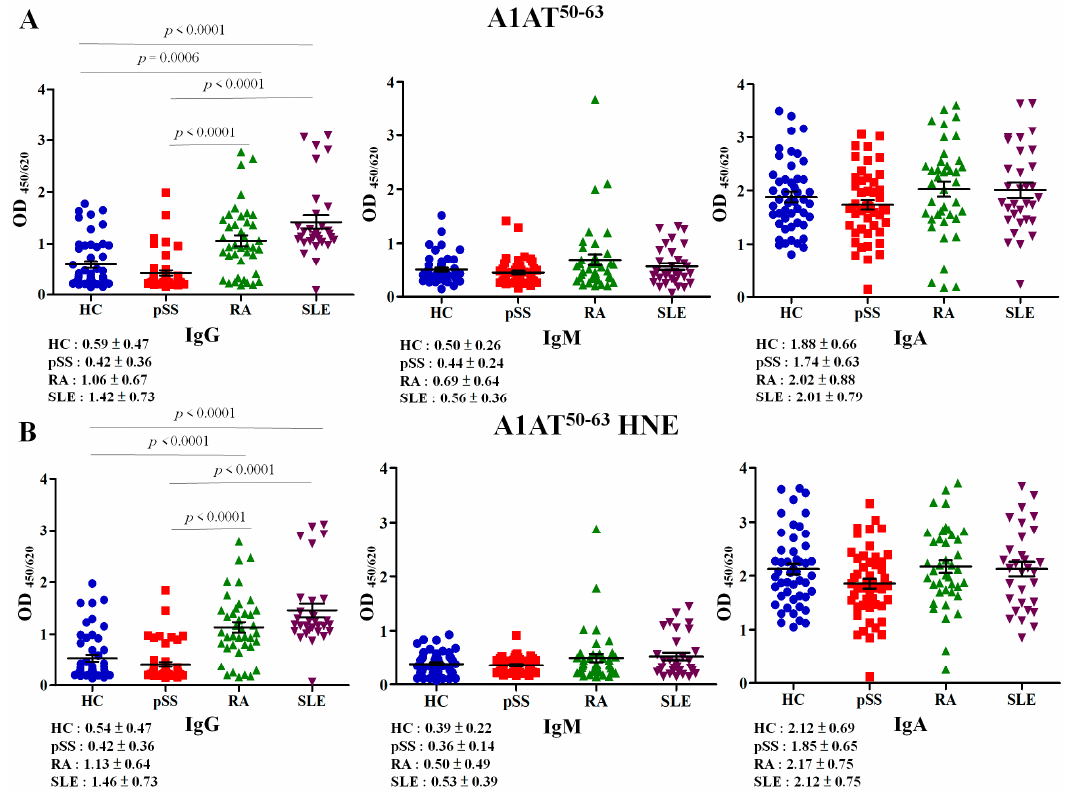
Figure 3. Dot plot of serum concentrations (absorbance units at 450/620 nm) of IgG, IgM, and IgA autoantibody isotypes recognizing A1AT 50–63 ( A ) and A1AT 50–63 4-hydroxy-2-nonenal (HNE) ( B ) in healthy controls (HCs), patients with primary Sjögren’s syndrome (pSS), rheumatoid arthritis (RA), and systemic lupus erythematosus (SLE) with an ELISA. OD 450/620 , optical density at 450/620 nm.